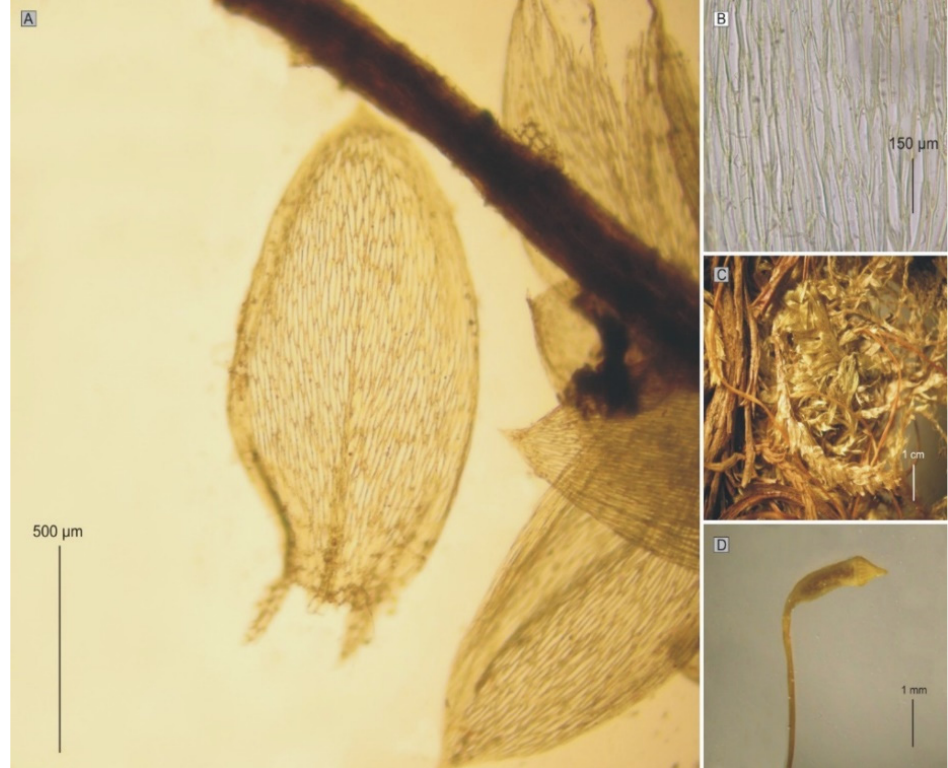
Figure 10. The most important taxonomic features of P . sandbergii : ( A ) leaves; ( B ) cells from the middle part of the leaf; ( C ) stems; ( D ) sporophyte (photo from PC0132604, PC0132605 by G.J. Wol- ski, Paris, November 2021). Paris, November